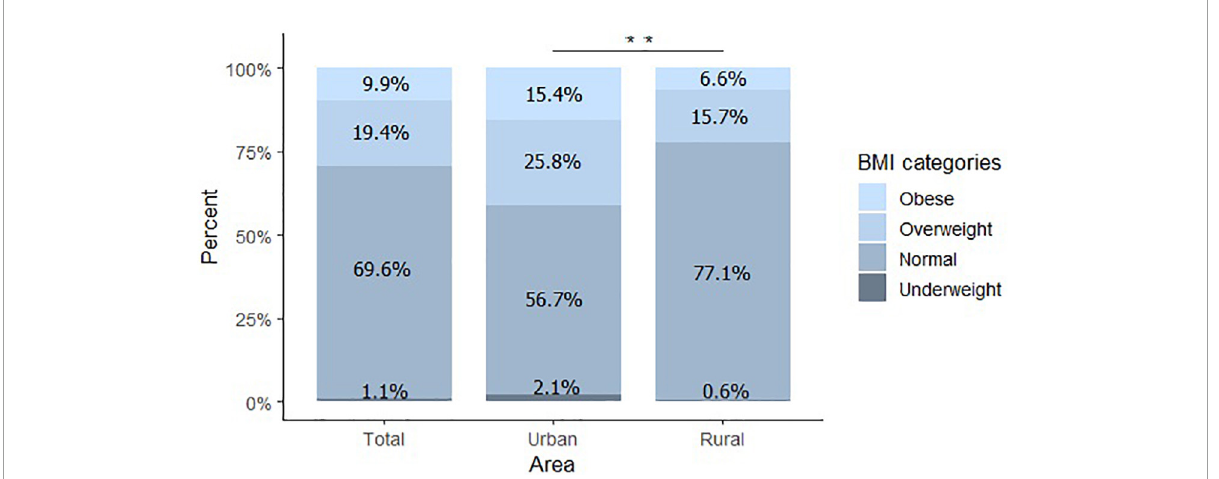
FIGURE1 Body mass index classification. Percentage of children obese, overweight, normal, and underweight. Total n = 263, Urban n = 97, Rural n = 166. ∗∗ P <